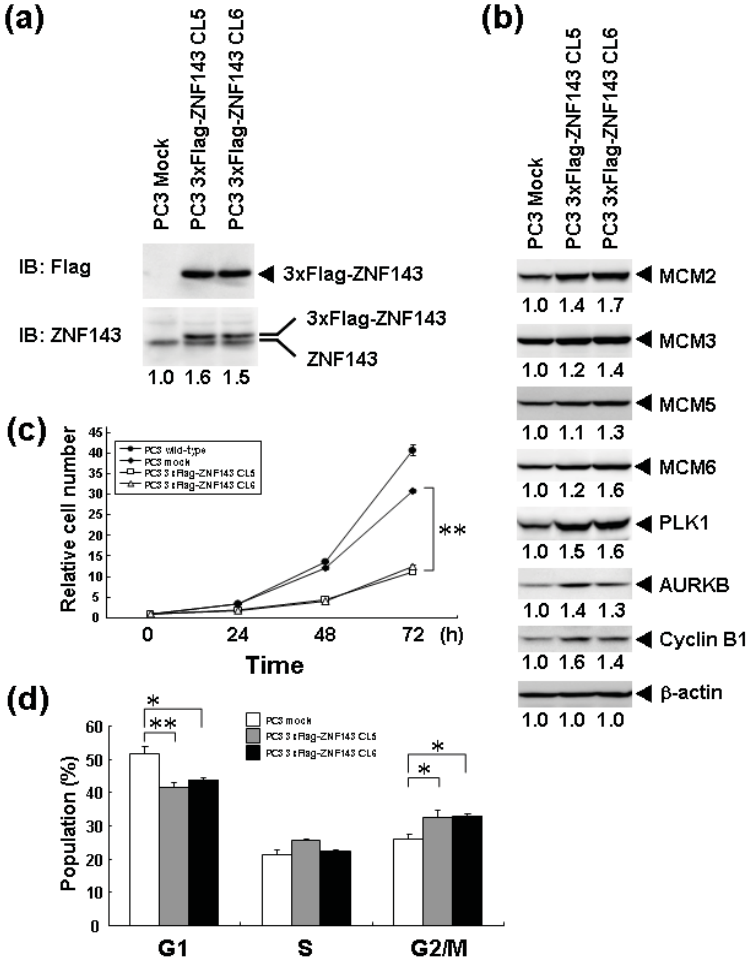
(10 0 μg) from PC3 cells with forced expression of 3xFlag-ZNF143 and mock transfected cells were used for Western blotting with anti-ZNF143 and anti-Flag antibodies; ( b ) Whole cell lysates (10 0 μg) of PC3 cells with forced expression of 3xFlag-ZNF143 cells and mock transfected cells were used for western blotting with the indicated antibodies. CL5 and CL6 represent different clones; ( c ) Cells were counted after the indicated times, with time zero being 24 h after seeding. The results were normalized to cell numbers at time zero. The points represent the mean of at least three independent experiments; the bars show the SD. ** P < 0.01; ( d ) PC3 mock and cells with forced expression of ZNF143 cells were harvested, stained with propidium iodide and DNA content in single cells was measured (cid:2) by flow cytometry. (cid:2) * P < 0.05, ** P <